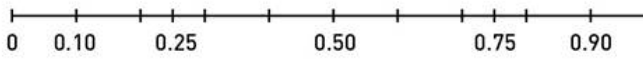
Figure 1. The BBN framework for maritime accident human error risk factor assessment. The mode values of the expert-assigned values were entered in the conditional proba- bility tables SMILE (structural modelling, interface, and learning engine) and GeNie GUI (graphical network interface) to create and quantify the Bayesian network [20]. The technique developed by Van der Gaag was used for allocating the conditional values within the network as this technique allows a fast and simple allocation of values to several hundreds or thousands of conditional probabilities of expert thinking [21]. Figure 2. A probabilistic scale is a horizontal or vertical line with numerical values. The values offered to the experts were: (0.1, 0.25, 0.5, 0.75, 0.9).